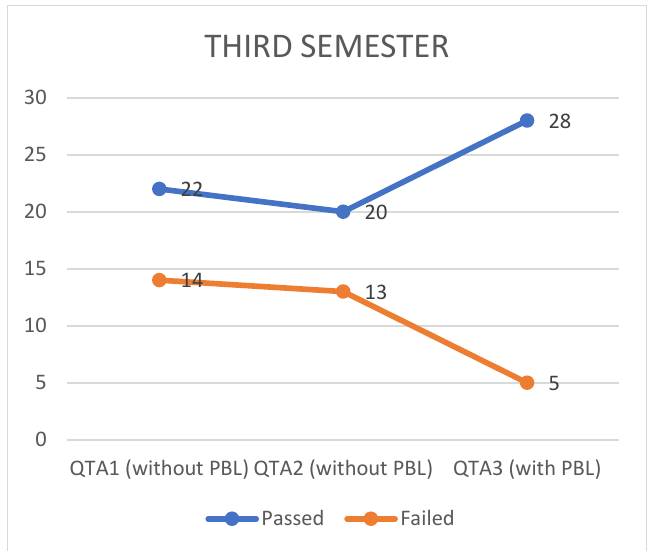
Fig. 7. Comparisons of PBL use in the third semester. Source: